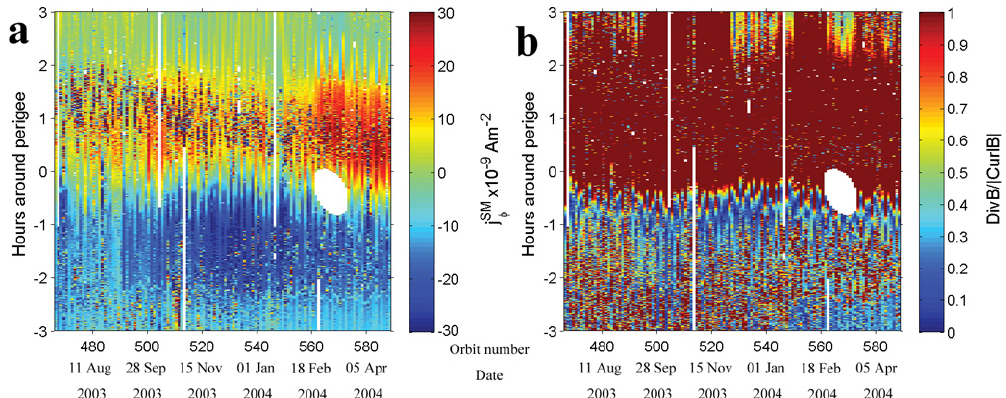
Fig. 3. Plots of φ components of the current density in SM coordinates around Cluster perigee crossings between 14 July 2003 (195/2003, orbit number 468) and 27 April 2004 (118/2004, orbit number 589). Each vertical strip is a section of an orbit – the x-axis is the orbit number, y-axis is time relative to perigee, and the colour scale is the value of J SM and Div( B )/ | Curl( B ) | , for the panels of (a) and (b) , respectively. φ